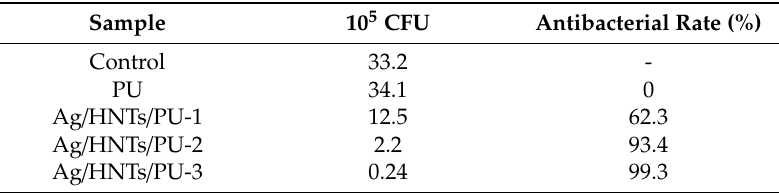
Figure 12. Bar chart illustrating the antibacterial e ff ect of Ag / HNTs / PU on E. coli , based on the quantitative analysis conducted. Table 6. Quantity of residual bacteria and antibacterial rate, as revealed by the quantitative analysis of Ag / HNTs / PU versus E.